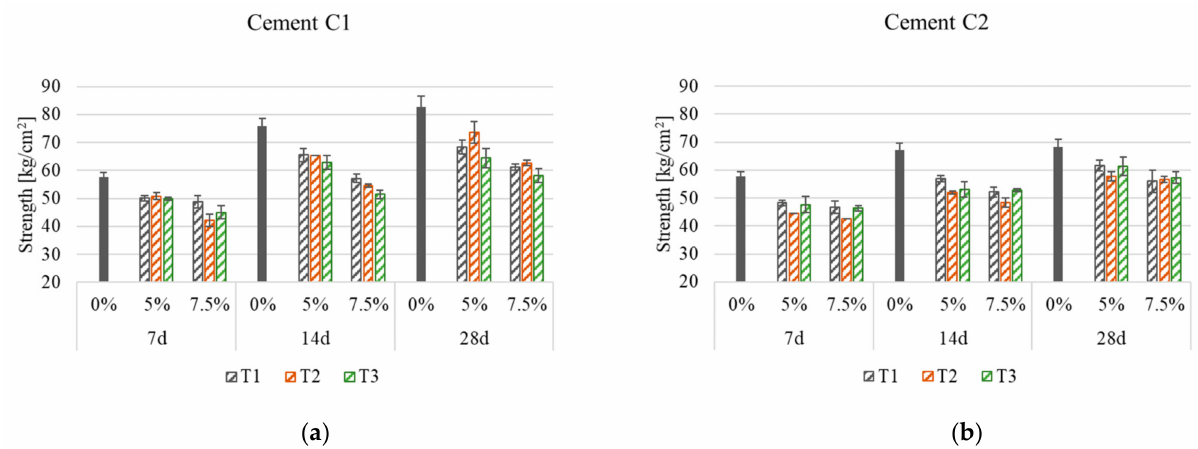
Figure 13. Flexural strength of rubber-added mortar samples under treatment R1 at 5% and 7.5% replacement, after 7, 14, and 28 days: ( a ) cement C1; ( b ) cement